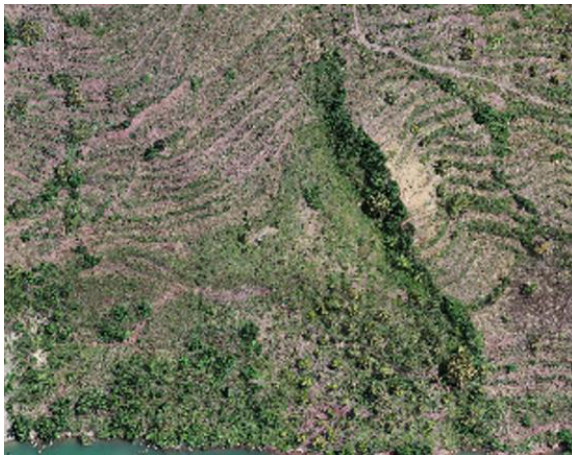
Figure 10 . Generalized orthophoto of deformed Regions in 2021. Table 1 . The magnitude and direction of the displacement. The results of obtaining corresponding image points based on multi-period generalized orthophoto matching are shown in Fig. To illustrate the effectiveness of the method proposed in this paper, we compared the monitoring results with the GNSS detection results, and the selected comparison points are shown in Figure 13.